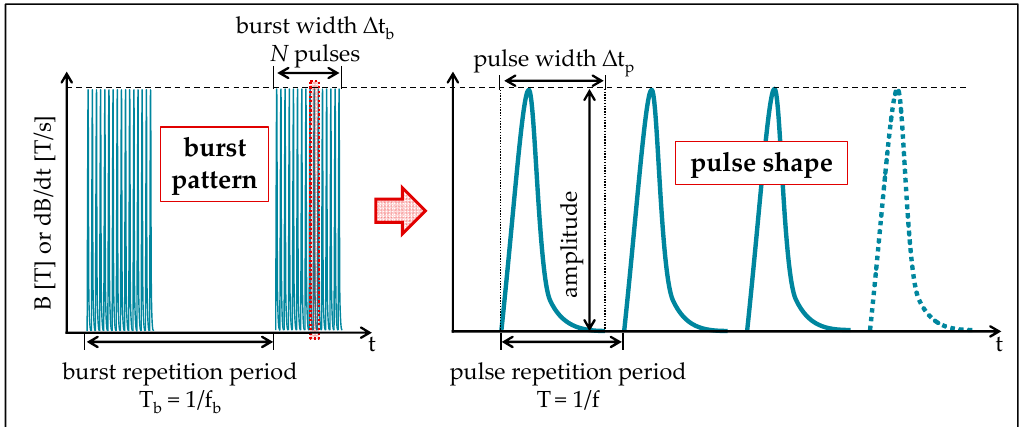
Figure 2. Schematic overview of the terms used for characterizing bursts and pulses of ELF-PEMF. PEMF-signals use periodically repeated bursts consisting of a certain number of pulses, N , at a certain frequency, f. The pulses can be described by their shape, amplitude, and pulse width, ∆ t p . Here, bursts are repeated at the burst-frequency f b (cid:28) f. Some publications refer to the magnetic flux density, (cid:2926) B, or the time-derivative of the magnetic field, dB / dt, others only state the search coil induction voltage. However, without knowing the exact search coil dimensions, the magnetic field amplitude cannot be derived from this